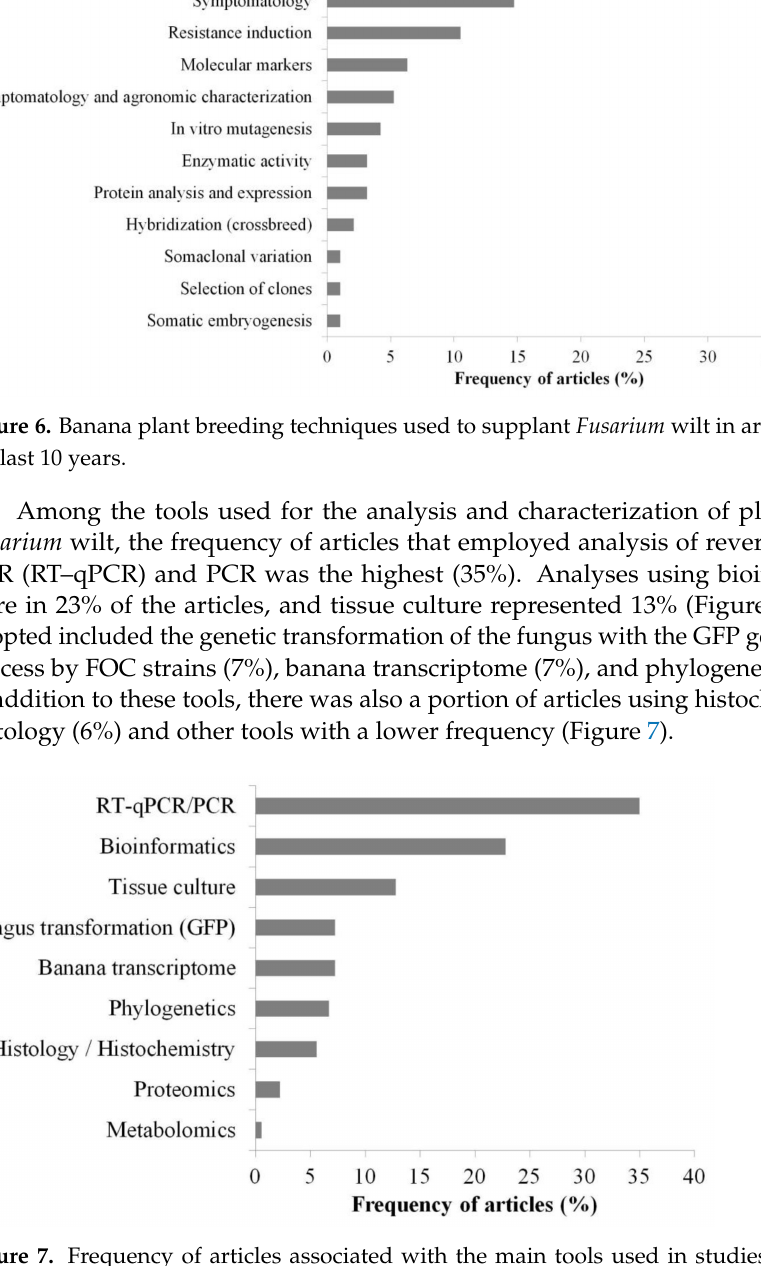
Figure 7. Frequency of articles associated with the main tools used in studies on banana plant breeding to Fusarium wilt in the last 10 years. The frequency considered that more than one tool was used per article. RT–qPCR/PCR: reverse transcription-PCR/polymerase chain reaction/ GFP: green fluorescent